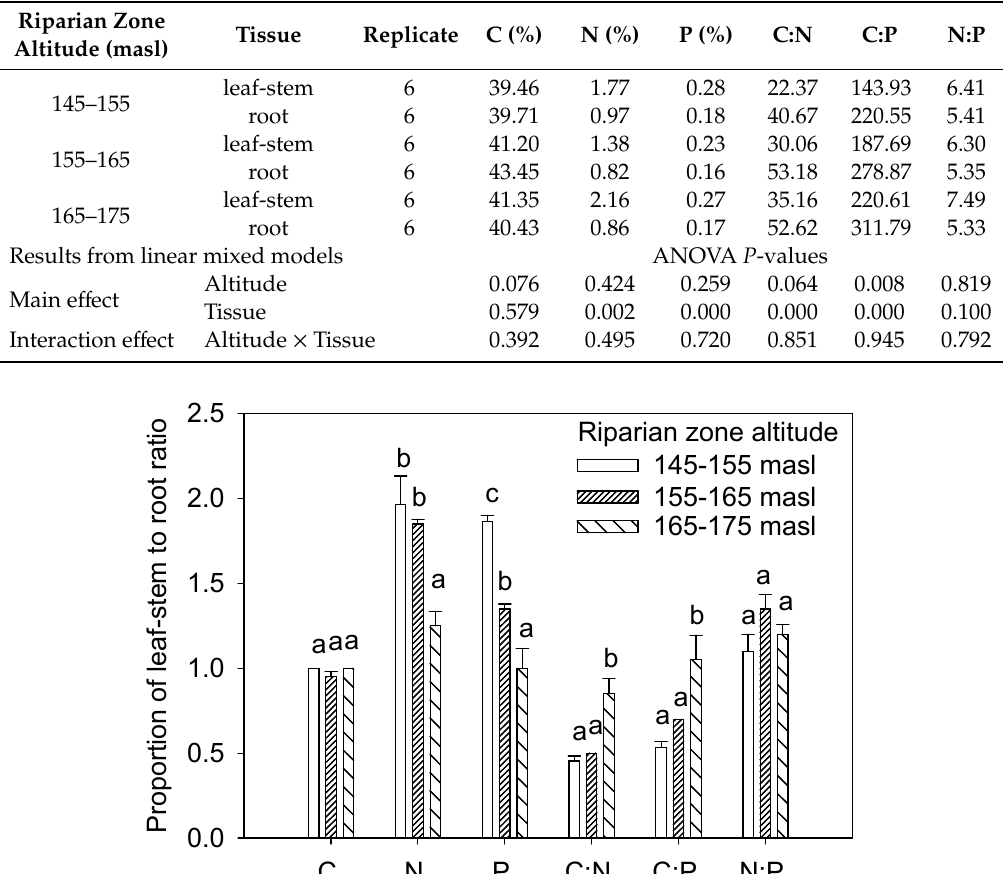
Figure 3. Net primary production (NPP) ( a ) and biomass ( b ) of C. dactylon among the riparian zone altitudes. Table 1. Leaf-stem and root C:N:P stoichiometric ratio among riparian zone altitudes and results from linear mixed model.